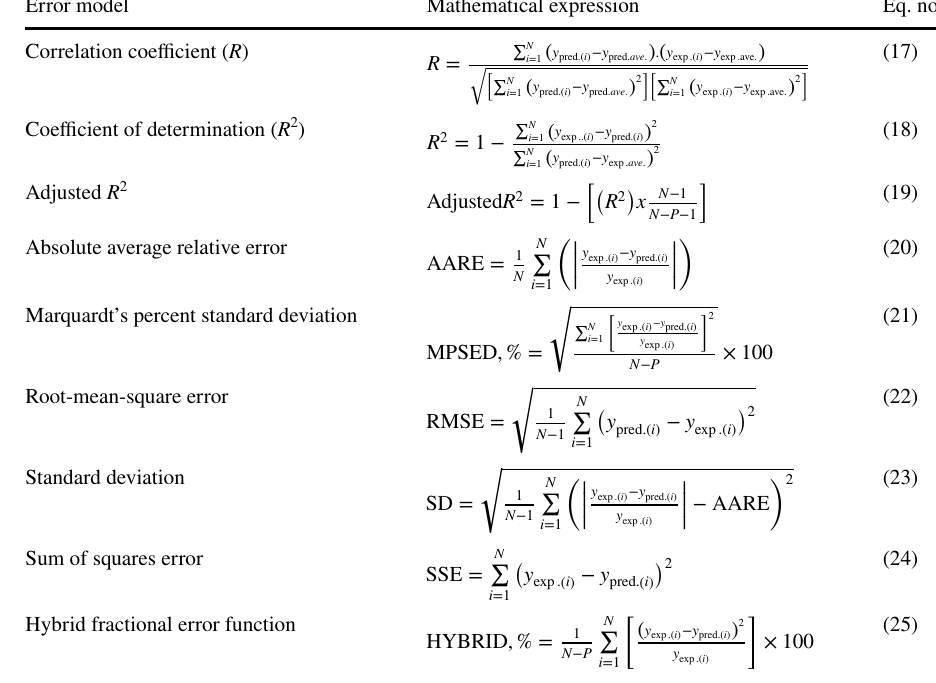
Table 2 The error function and adsorption mechanistic